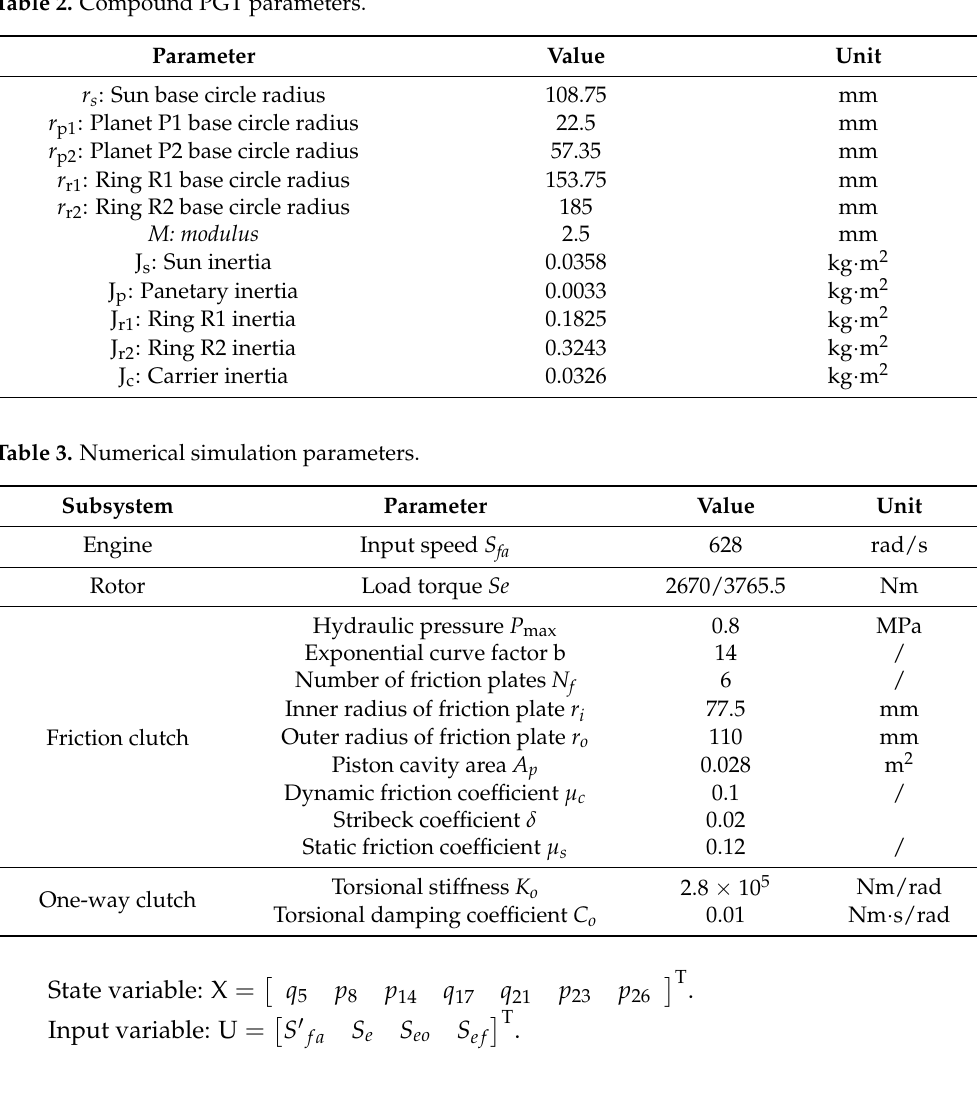
Table 2. Compound PGT parameters.